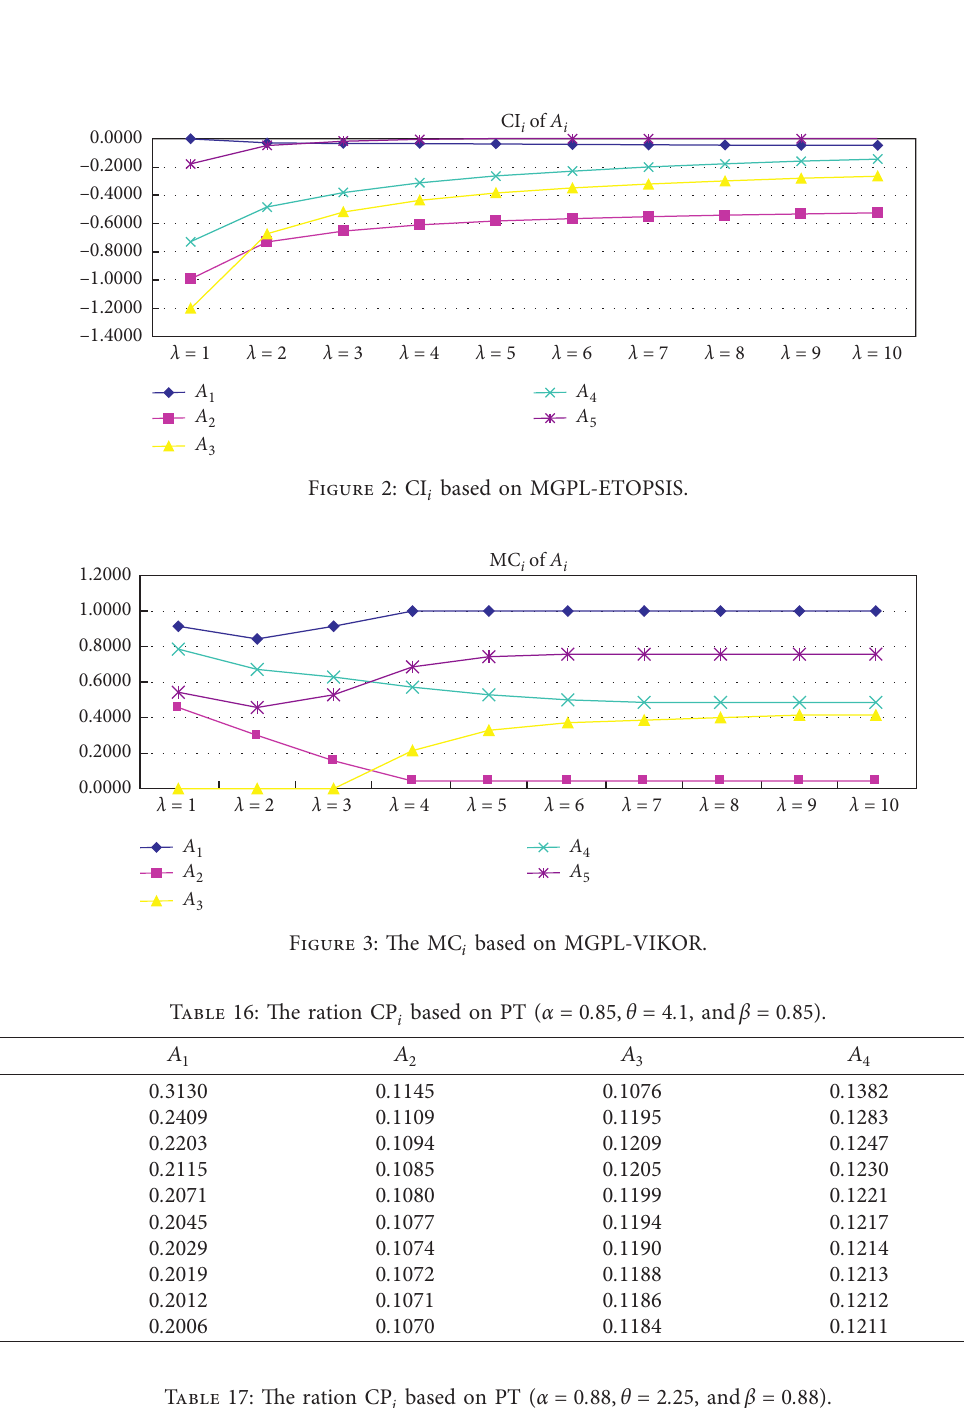
� 0 . 88 , θ � 2 . 25 , and β � 0 . i based on PT ( α